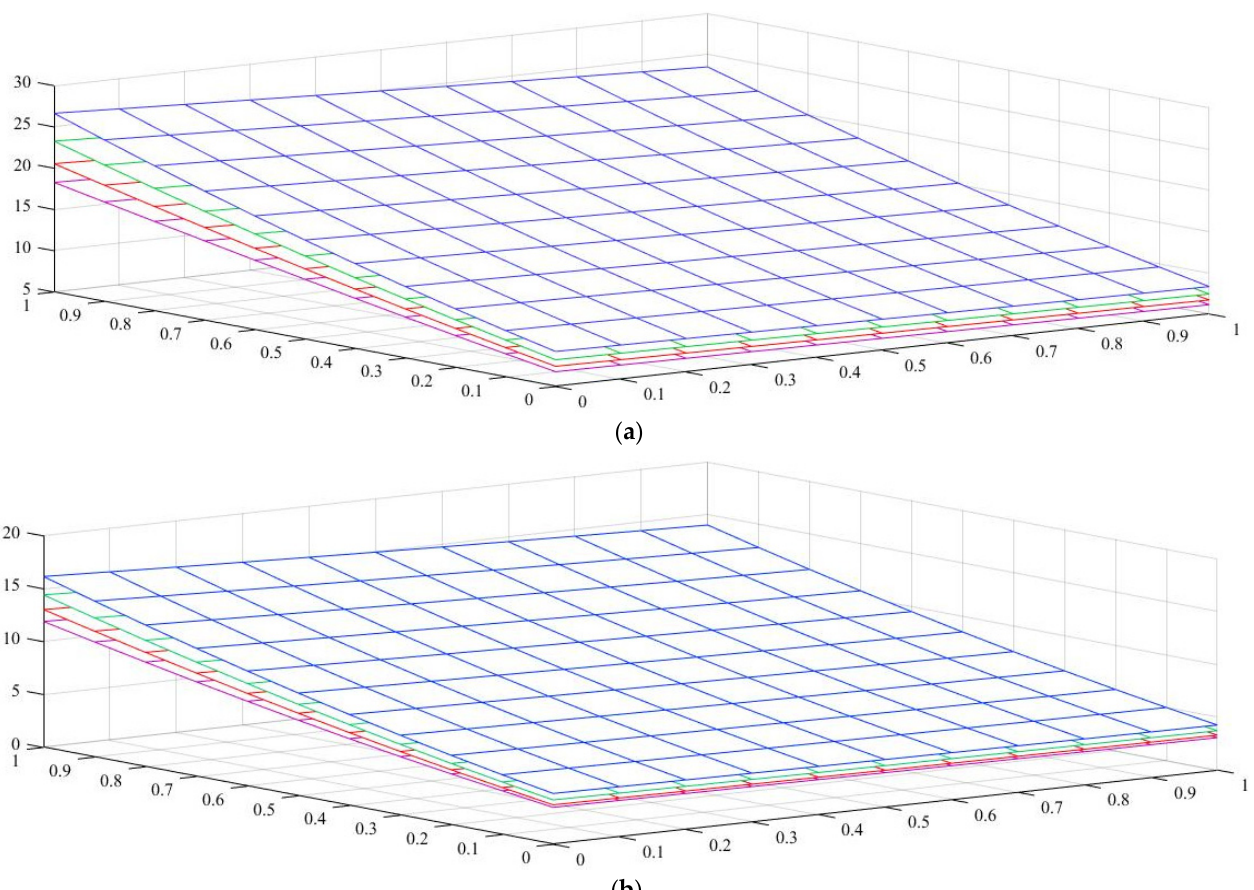
( ) P of local and nonlocal beams with a tapered I-section for various Figure 6. Variation in normalized buckling load nor webs. Effect of the power-law exponent and tapering parameter on the normalized torsional buckling load simply supported thin-walled nanobeams with different nonlocal parameters (axial load applied on the Centroid): ( a ) ( pure ceramic, ( b ) AFG